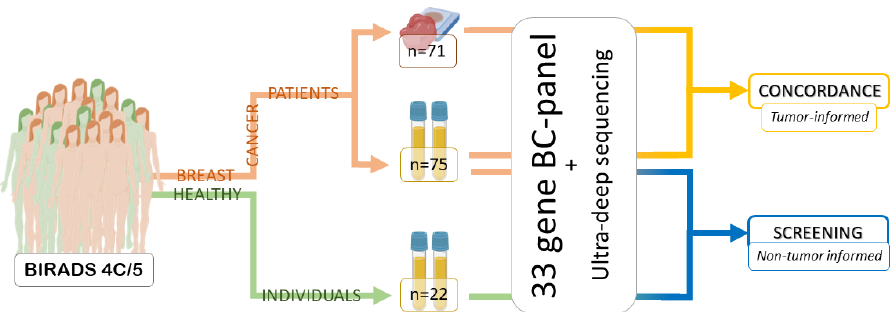
Figure 1. Workflow of the study. Patients with suspicious mammogram results (BIRADS 4C/5) were recruited and blood samples extracted prior to any medical procedure, together with fresh-frozen diagnostic tumor biopsies. Women with negative biopsies for BC were used as controls for the study. Then, a custom BC capture panel and ultra-deep sequencing were employed to analyze for concordance between tumor and plasma as well as to perform a non-tumor informed